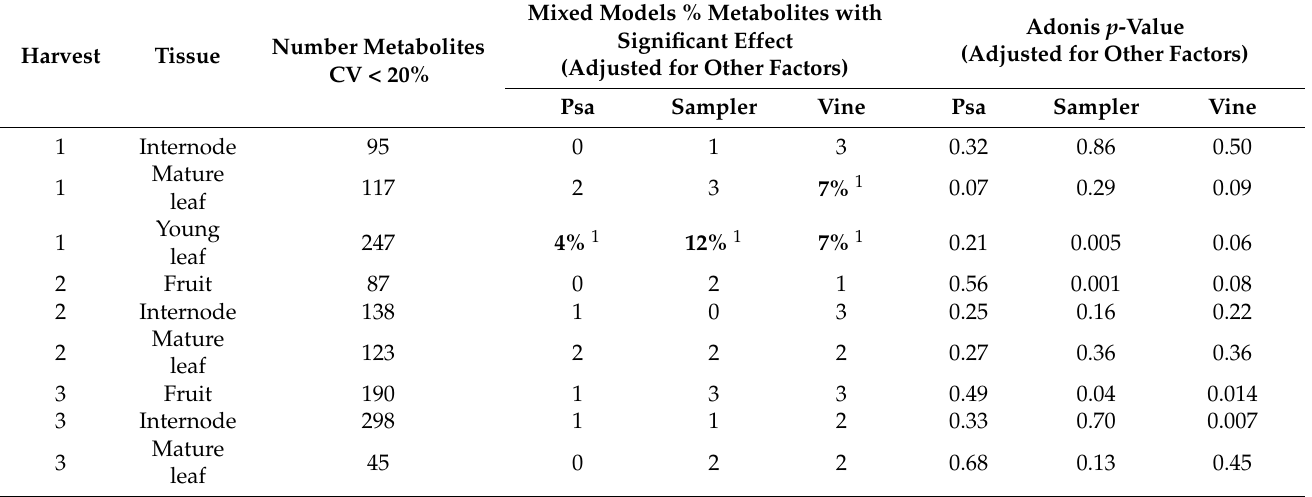
Table 3. Comparison of results of ANOVA and Adonis analysis of Pseudomonas syringae var. actinidiae (Psa) infection of vegetative tissue, sampler, inter-vine variation and rootstock on variability of metabolomics analysis of ‘Hayward’ kiwifruit tissues collected at three harvest times. Percentages in bold show more significant effects than expected by chance (ANOVA) or p < 0.05